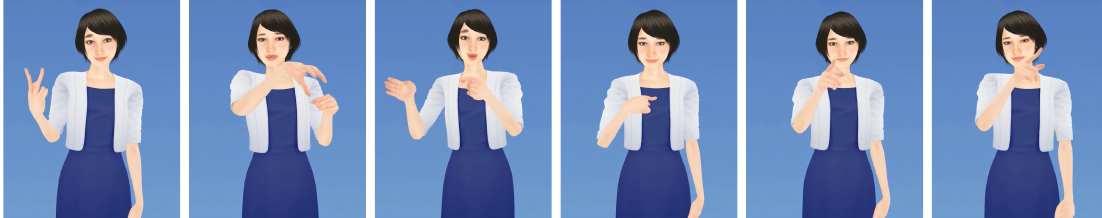
Figure 4. Sign avatar visualization of some of the JSL items for spatial and contextual references present in the corpus. From left to right: CP for two people (‘CP (2ppl)’), CP for places (‘CP (P)’), CP for buildings (‘CP (BL)’), pt1, pt2 and